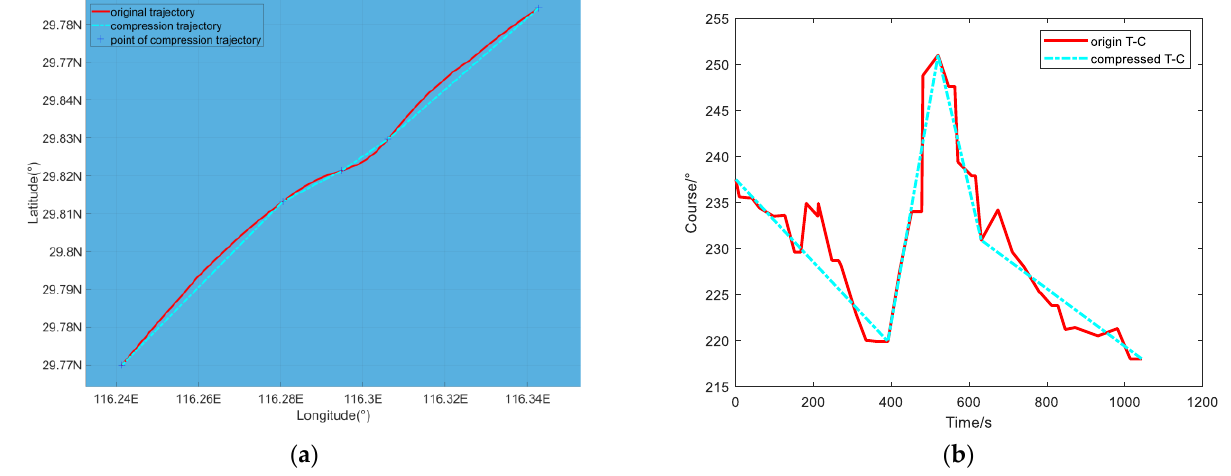
Figure 12. AIS data before and after compression. ( a ) Before and after comparison of track positions. ( b ) Time-Heading before and after compression.